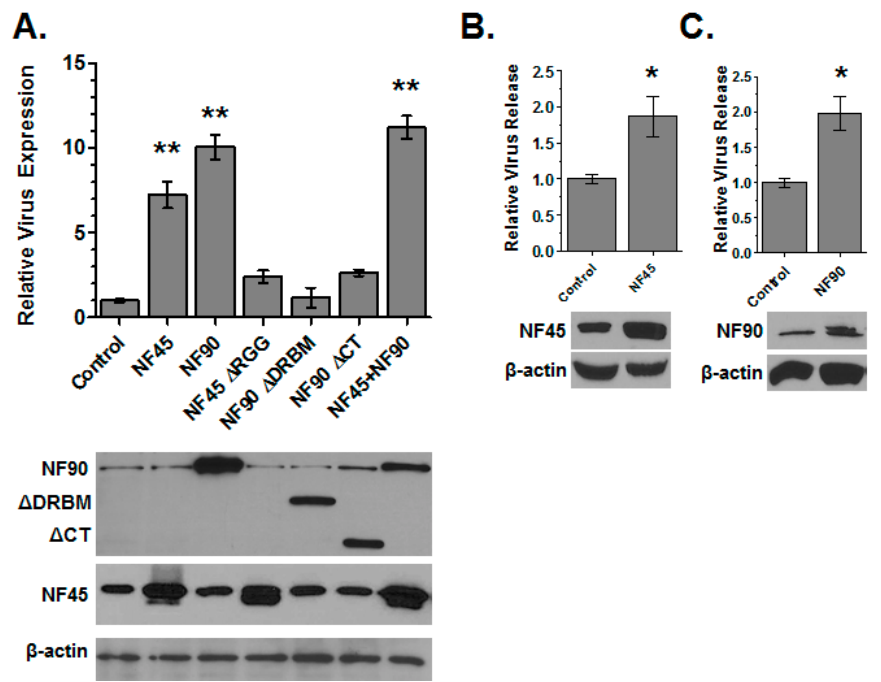
Figure 3. NF45 and NF90 potentiate HIV gene expression. ( A ) Expression assays. HIV-Luc plasmid was co-transfected with indicated expression plasmids or empty pcDNA3.1 as a control. At 48 h post transfection, cells were harvested and gene expression quantified by Luc assay, which was normalized to protein concentration. Protein overexpression was confirmed by immunoblot using β -actin as a control ( B , C ) Virus production assays. Cells were co-transfected with pNLX molecular clone and NF45 ( B ); NF90 ( C ); or pcDNA3.1. The next day the media was changed, and the cells incubated an additional 8 h before the supernatants were collected. Virus release was measured by in vitro reverse transcriptase assay and are presented relative to the control group. Protein expression was monitored by immunoblot using β -actin as a loading control (bottom panels). Plots show the total data from three independent experiments with triplicate transfections; blots are representative of all three experiments.